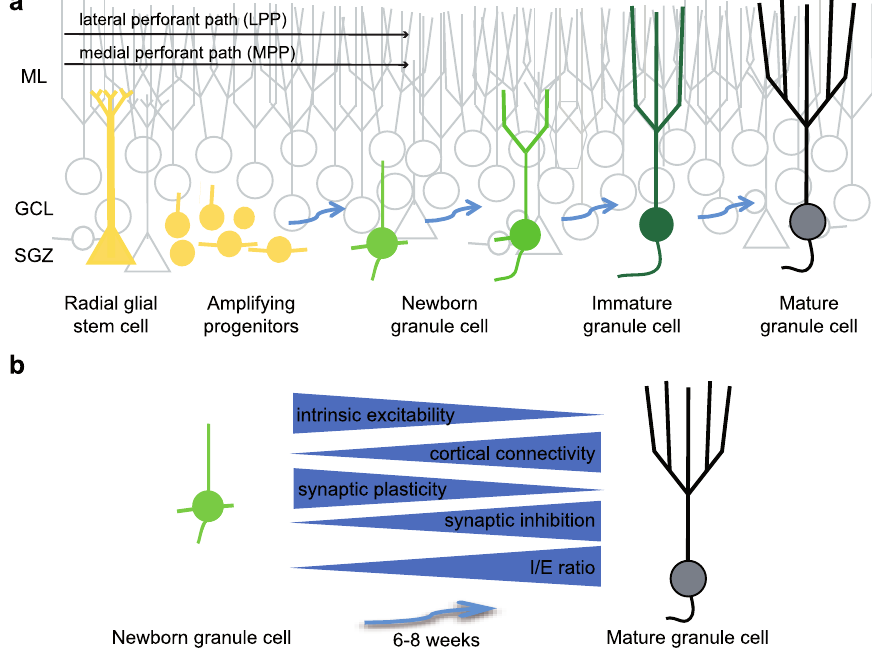
Figure 1. Functional maturation of adult-born granule cells. a . Illustration of the morphological maturation and integration of adult-born granule cells (GCs) (green cells) in the dentate gyrus. Progressive stages of integration are indicated by blue arrows. Yellow cells represent radial glial stem cells and proliferating progenitors. Developmentally generated GCs are gray and the molecular layer (ML), GC layer (GCL), and subgranular zone (SGZ) are indicated. GC dendrites extend through the ML and axons (truncated) project to CA3. b . Summary of the physiological changes that accompany morphological maturation of GCs. Full maturation typically requires 6 to 8 weeks in young adult mice. Blue arrows indicate direction of change, with intrinsic excitability and plasticity decreasing with maturation but synaptic connectivity from the cortex and synaptic inhibition increasing with maturation. The changes in adult-born GC intrinsic and synaptic properties during maturation are reviewed in 20–23.